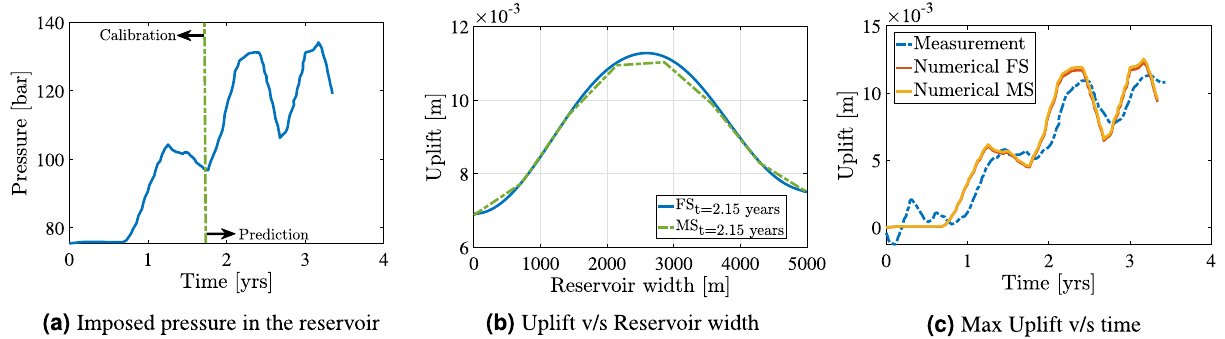
Figure 10. Field scale test case: the above illustration shows the results of uplift obtained from the reservoir model with inelasticity. Figure 10 (a) shows the variation of imposed pressure with time indicating the calibation and prediction phases. Figure 10 (b ) shows the uplift computed at time = 2.15 years for both FS and MS methods. The variation of uplift with time is shown in Fig. 10 (c ) with the GPS measurement data 28,92